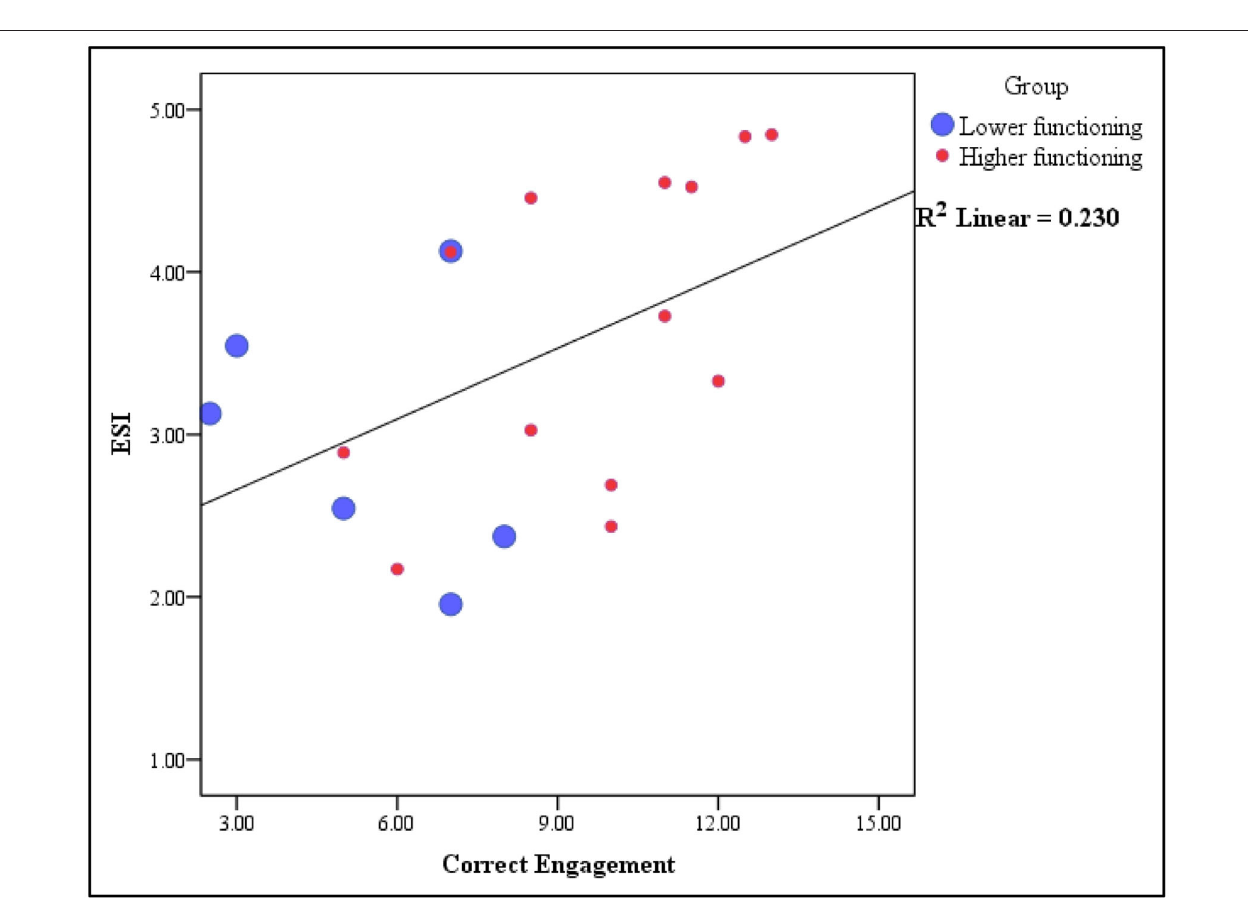
Frontiers in Computer Science |